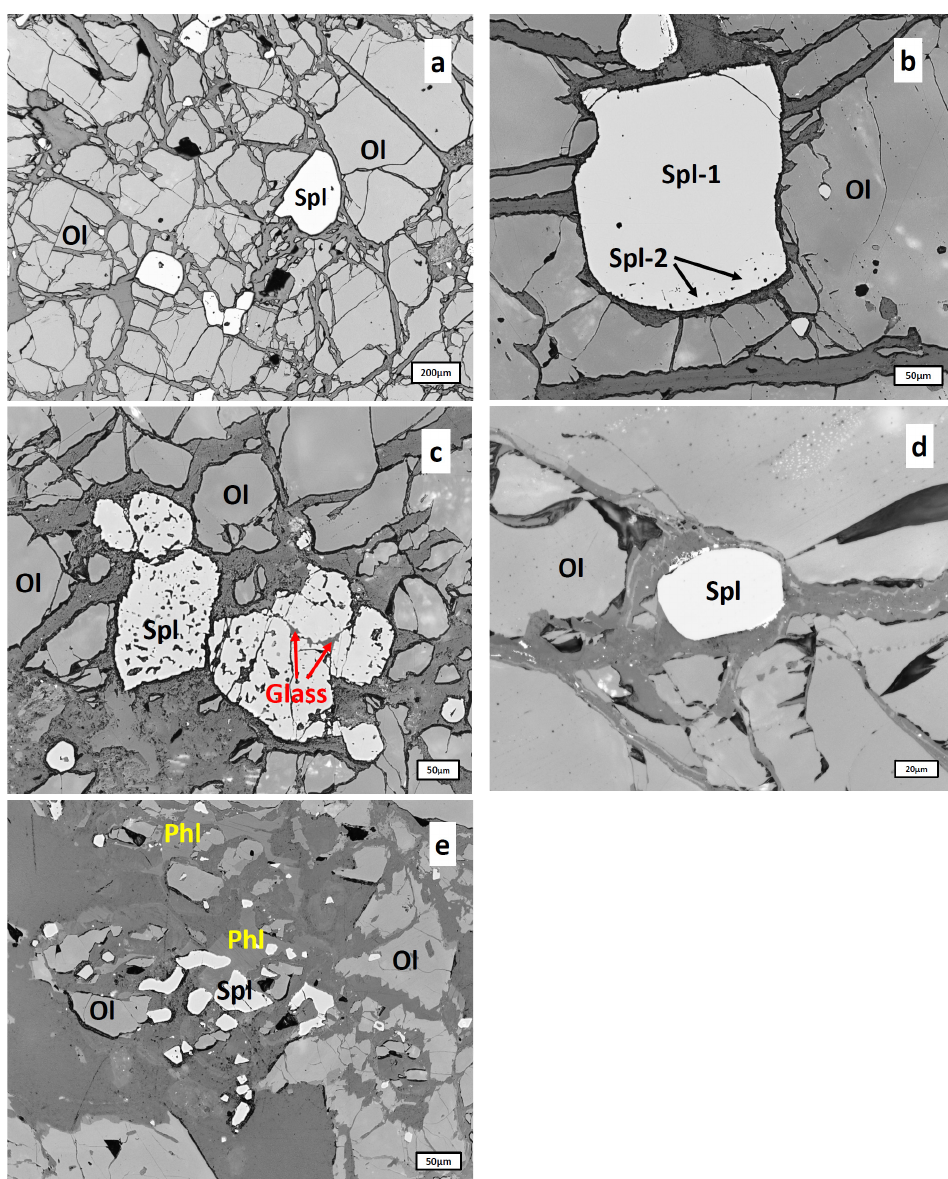
Figure 7. Types of spinels from dunites: ( a ), primary spinel (Spl) represented by clean homogeneous grains; ( b ), a tiny rim of resorption (Spl-2) starting to develop around the primary spinel grain (Spl-1); ( c ), completely resorbed interstitial spinel grains (Spl) containing patches of silicate glass (light-grey) inside the “spongy” material of spinel (all from the sample SN-N6); ( d ), clean homogeneous spinel grain (Spl); ( e ), irregular to skeletal spinel grains (Spl) in altered (serpentinized) silicate matrix containing phlogopite (Phl) ( d ) and ( e ) are from the sample SN-N9); see text for details. Ol, olivine.